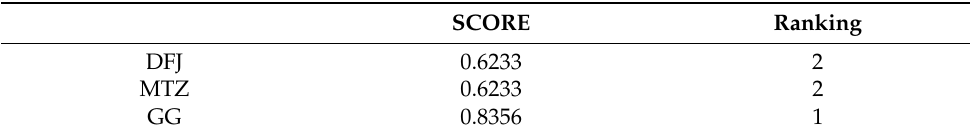
Table A5. Ranking of alternatives by